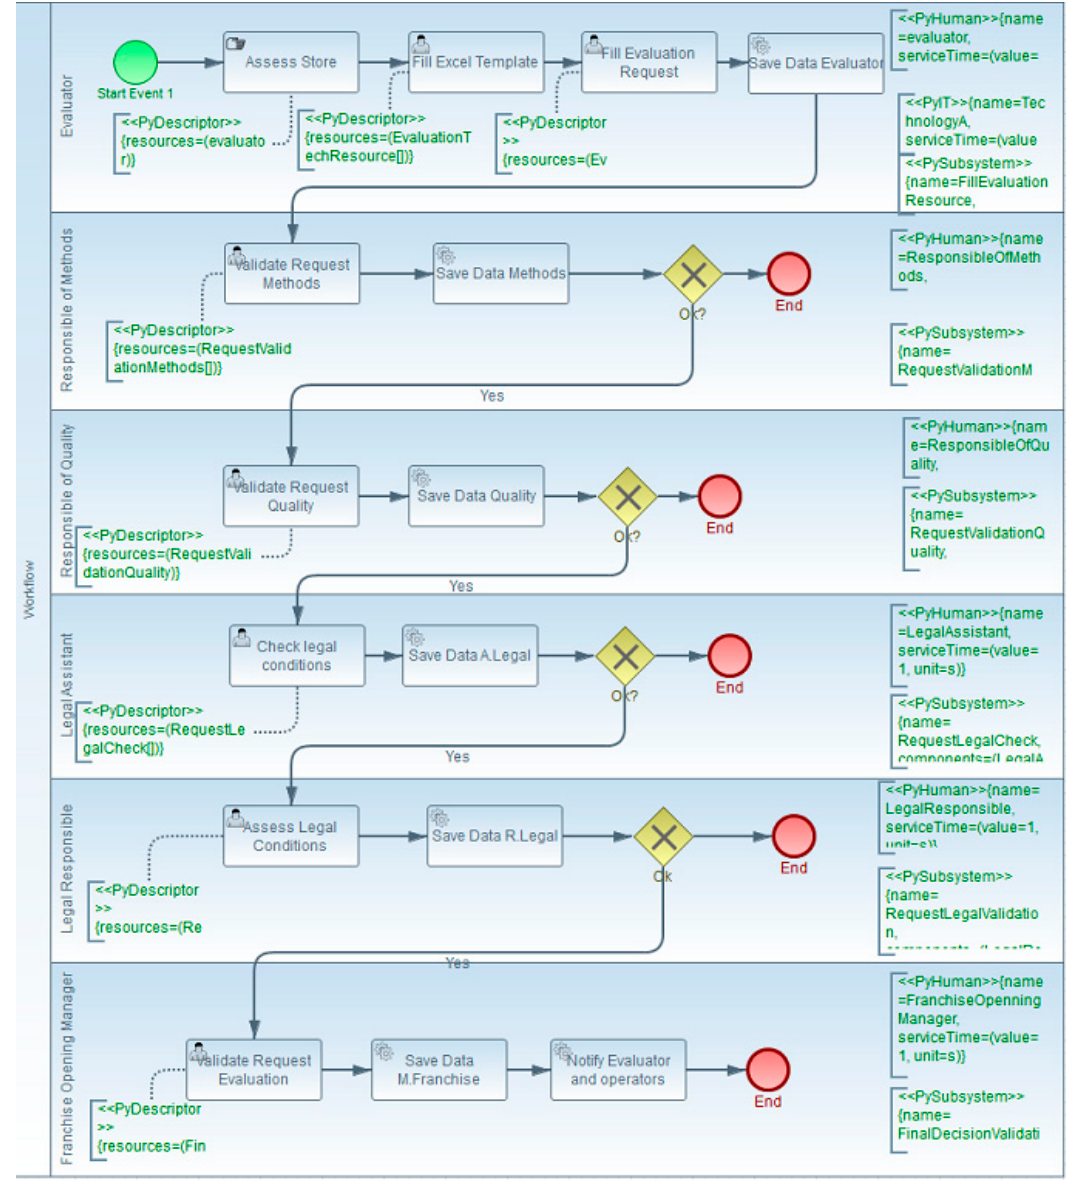
Figure 13. Operational process modeling. 524